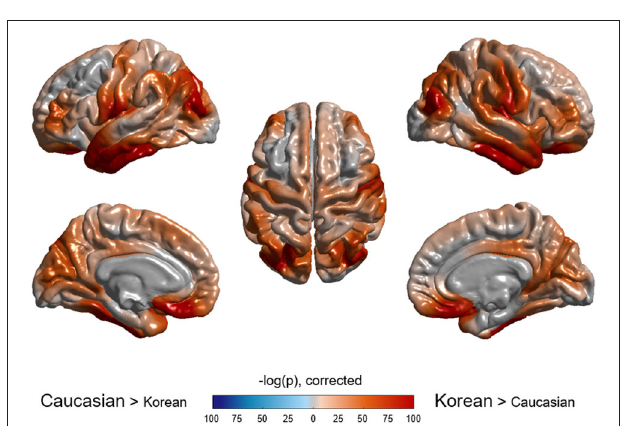
FIGURE 3 | Vertex-wise comparison of cortical volume between Caucasian and Korean normal controls. Korean elderly people were bigger in cortical volume than Caucasians. The p -value of ethnicity as a predictor was computed at each vertex based on the regression model described in the method